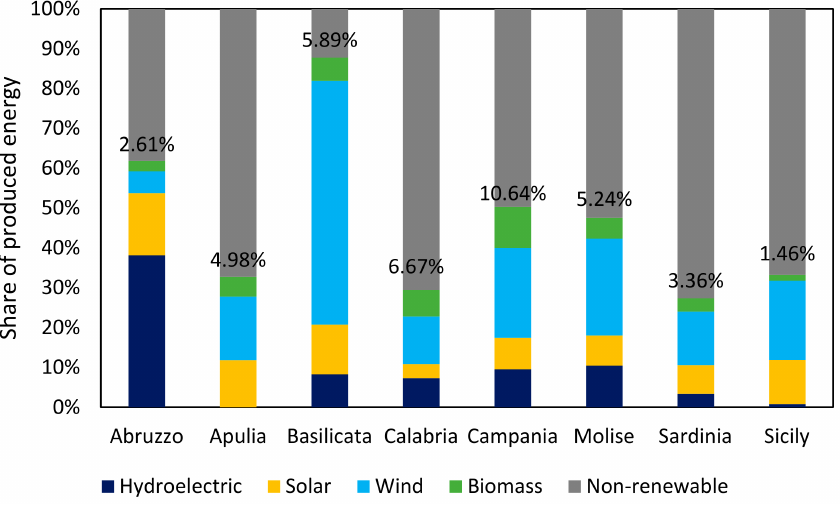
Figure 4. Source of electricity in Southern Italy; the percentages emphasise the share of bio-energy (data adapted from [54] by Terna spa, www.terna.it).